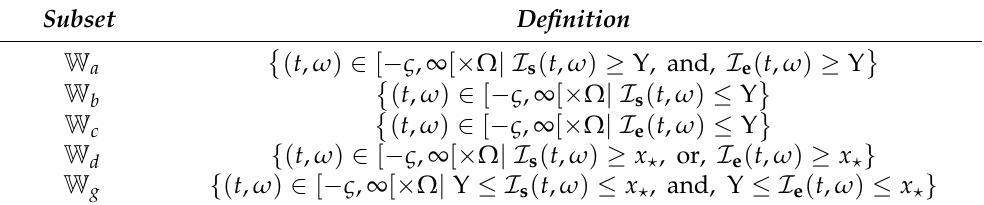
Table 1. Definition of some subsets used in the demonstration of Theorem 1, where x (cid:63) > Υ > 0 are two constants to be selected